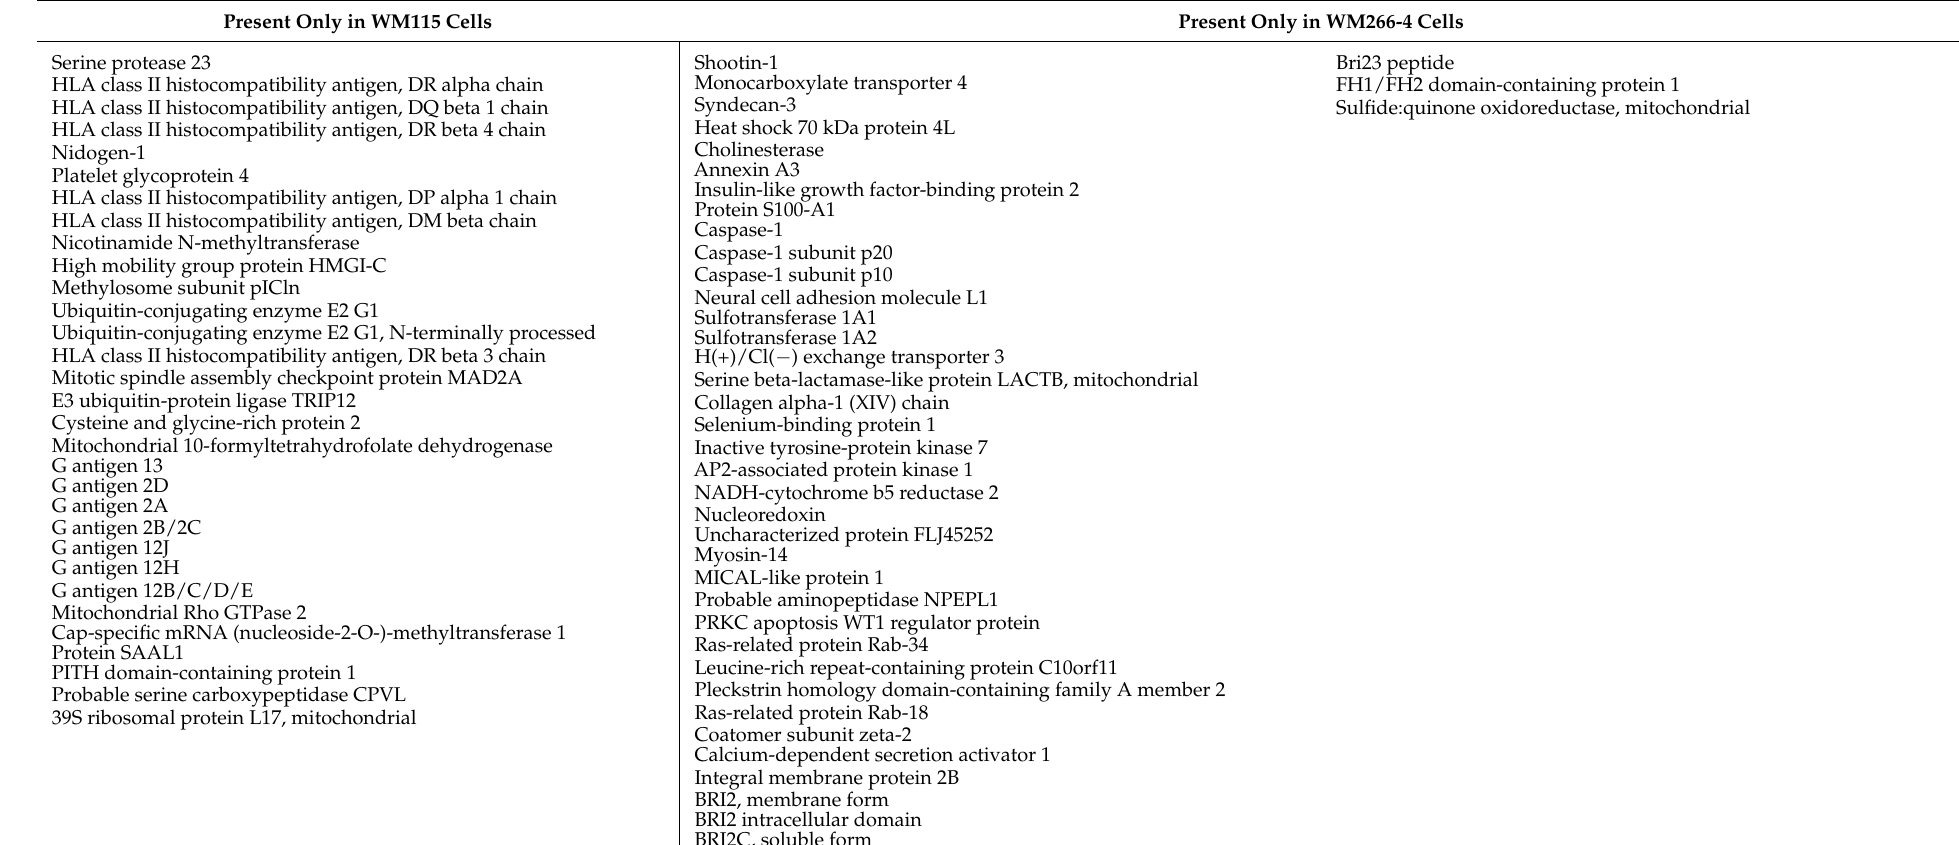
Table 2. List of proteins identified in WM115 cells but not found in any replicates of WM266-4 cell samples and vice